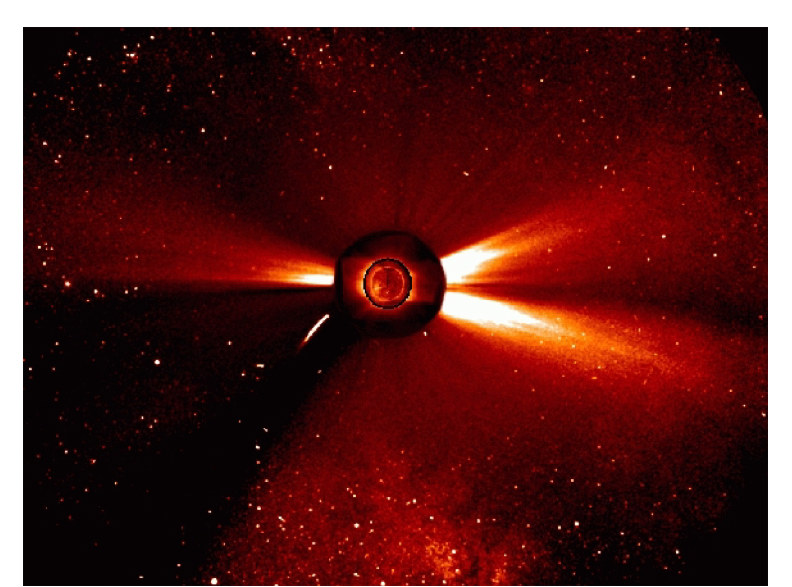
Figure 2. Composite SOHO image taken in 1996: innermost region showing in the iron line Fe XV 28.4nm the corona above the disk at a temperature of about 2MK, middle region showing the Sun’s outer atmosphere as it appears in ultraviolet light in the line O VI 103.2nm of oxygen ions flowing away from the Sun to form the solar wind and outer region showing the extended structured corona as recorded by the white-light coronagraph measuring the light scattered by free coronal electrons. A Sun-grazing comet is also visible as a bent trace on the